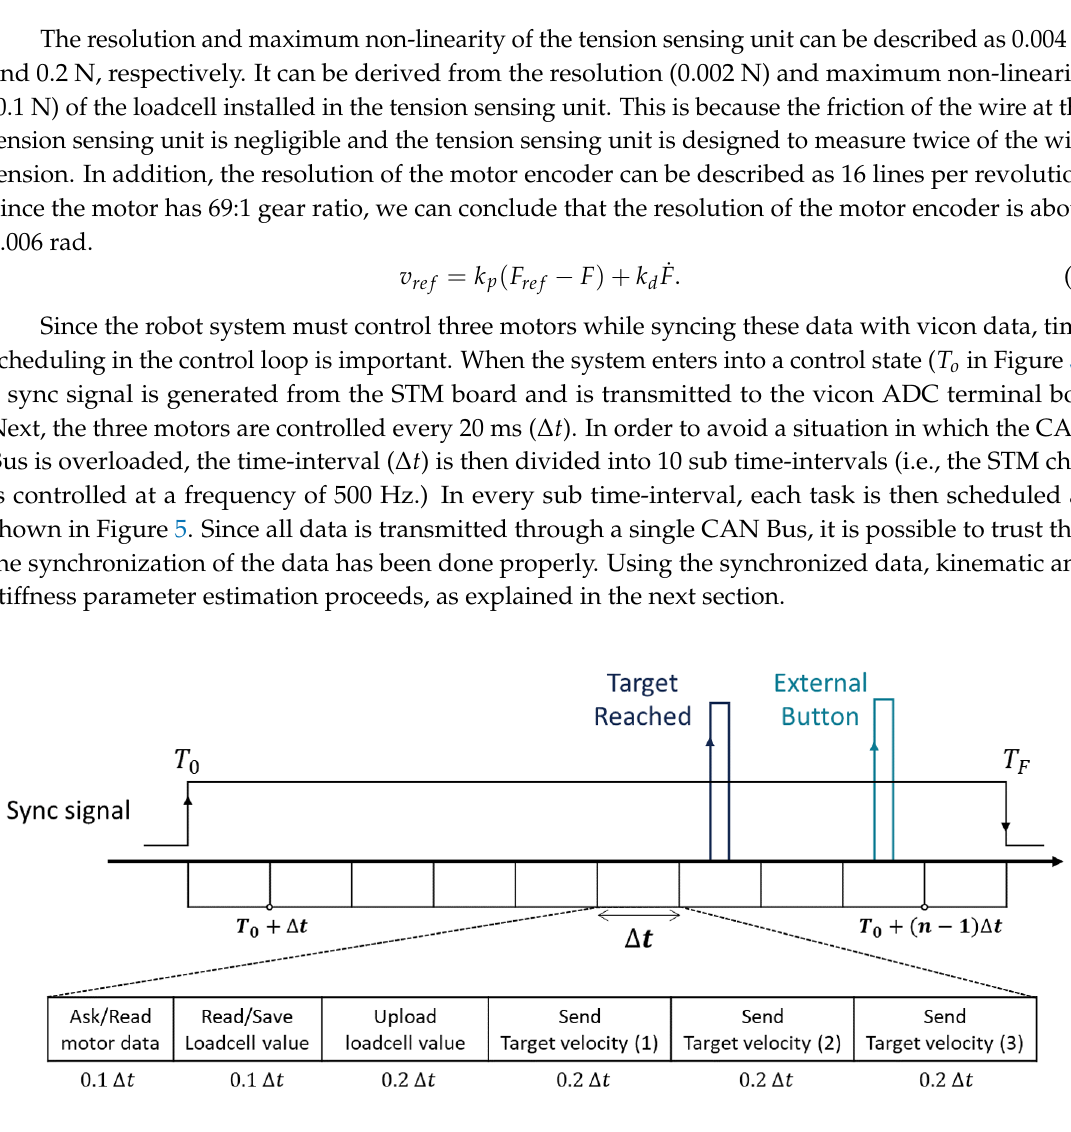
Figure 5. Schematic of time scheduling in the controller for reliable data